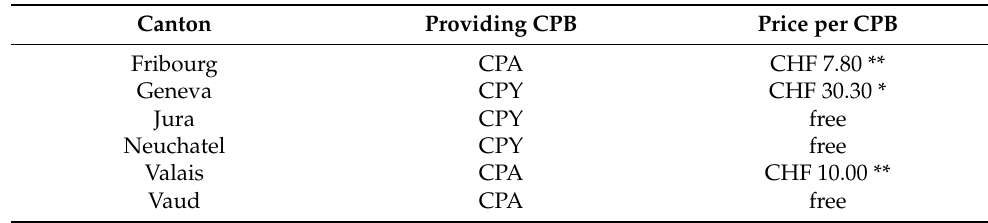
Table 1. Cantonal management of counterfoil prescription blocks (CPB) distribution. CPY and CPA stand for cantonal physician, respectively, and cantonal pharmacist.